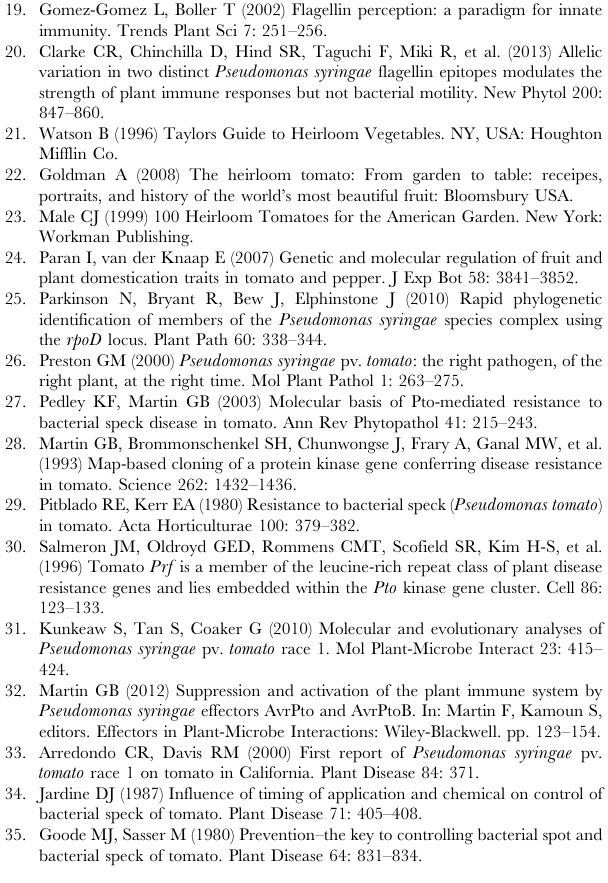
Table S1 Bacterial isolates from western North Car- olina compared with P. s. pv. tomato DC3000. Table S2 DNA primers and PCR conditions used in this study. Table S3 Comparison of features of the North Carolina isolates with other well-characterized P. s. pv. tomato strains. Table S4 Summary of responses to MAMPs and speck disease in the